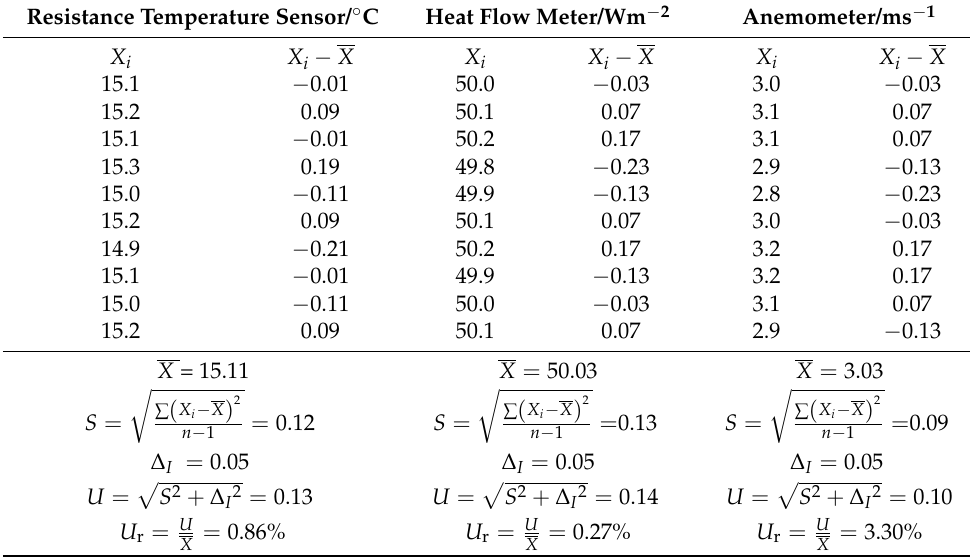
Table 3. Uncertainty calculation process.